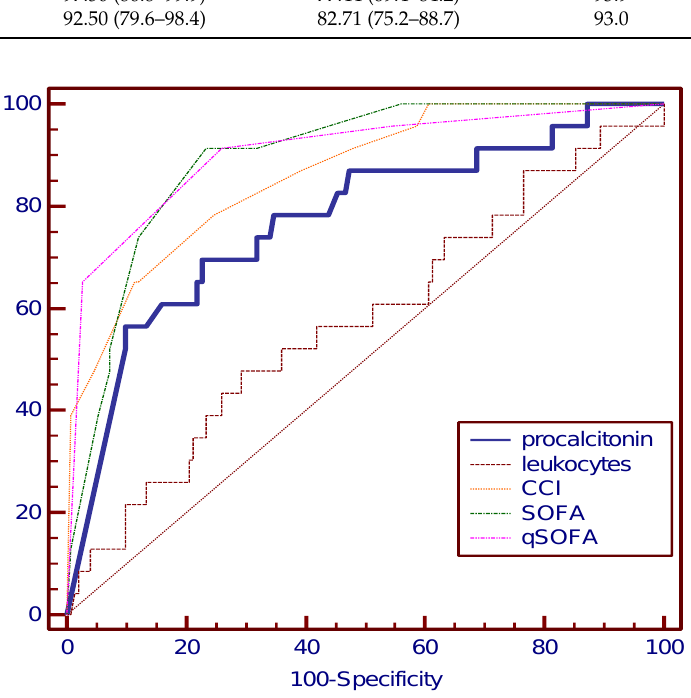
Figure 1. Pairwise comparison of ROC curves for the deceased group. For the SIRS group, PCT (specificity 91.30%, sensitivity 85.71%), SOFA (specificity 84.78%, sensitivity 78.74%), and qSOFA scores (specificity 84.78%, sensitivity 76, 34%) proved to be relevant in establishing the diagnosis. The most relevant parameter was PCT with a cutoff value of 4.8 (AUC 93%) (Figure 2, Table 2).